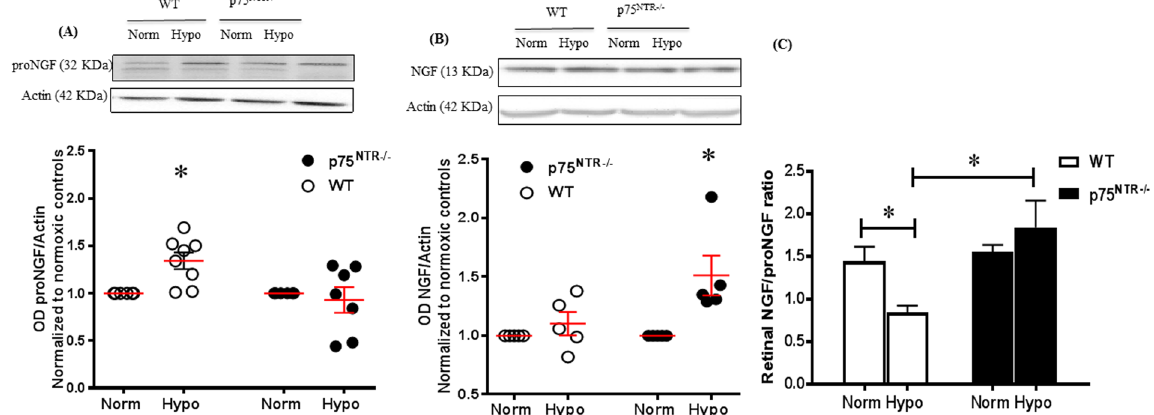
Figure 7. Deletion of p75 NTR attenuated hypoxia-induced increase in proNGF and restored ratio of NGF/ proNGF. ( A ) Representative Western blotting and scatter graph for proNGF showing that hypoxia caused significant increase in proNGF levels in retinas from WT-pups but not p75 NTR − / − compared to normoxic control at p14. ( B ) Representative Western blotting and scatter graph for NGF showing that hypoxia caused significant increase in NGF level in retinas from p75 NTR − / − , but not WT compared to their normoxic controls. ( C ) Bar graph of NGF/proNGF ratio and Two-way ANOVA statistical analysis showing significant decrease in retinal NGF/proNGF ratio in WT-pups during hypoxia while p75 NTR − / − pups maintained balanced ratio of NGF/proNGF ( * significant using Two-way ANOVA, p < 0.05, n = 5–7).